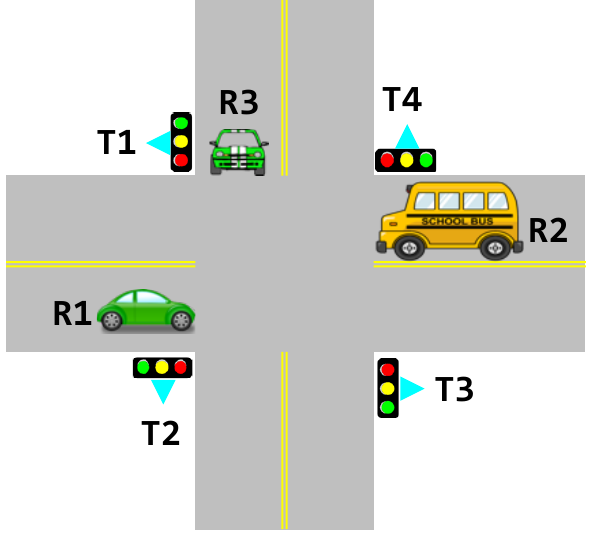
Figure 13. Power transmission simulation